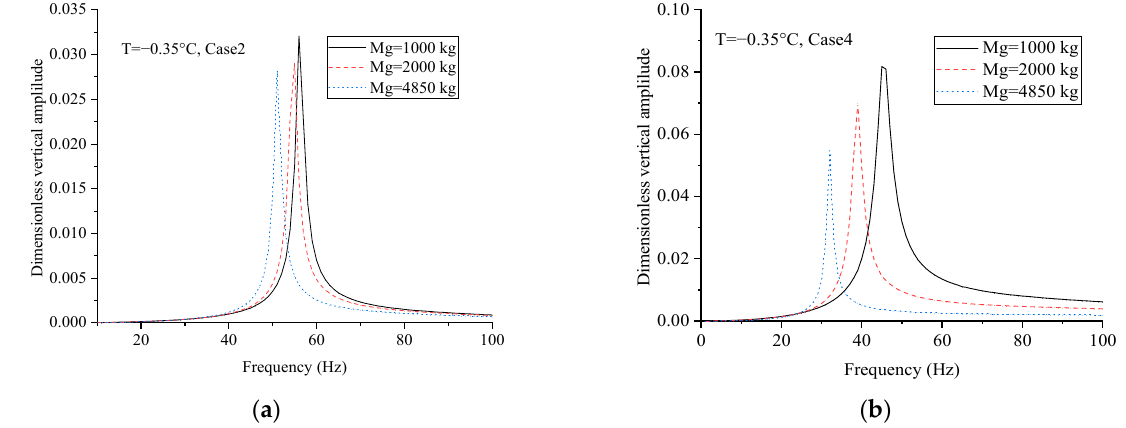
Figure 11. Influence of the pile cap mass on the amplitude–frequency curves of the single-pile foundation. ( a ) Case 2 and ( b ) Case 4.